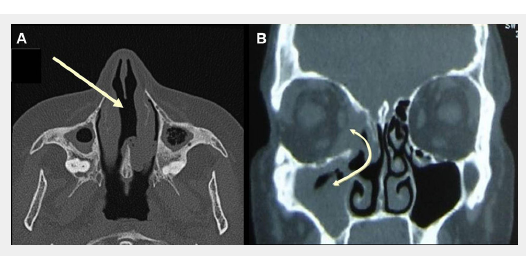
A) CT scan of the sinus in a patient with GPA, showing nasal septum perforation (arrow) and maxillary sinusitis with some degree of maxillary sinusitis and atrophy, with osteosclerosis and bony thickening of the paranasal sinuses. B) CT scan of the sinus in a patient with GPA showing sinusitis and sinus wall erosion leading to the formation of a communication (fistula) between right maxillary sinus, nasal cavity and orbit (double-headed arrow).